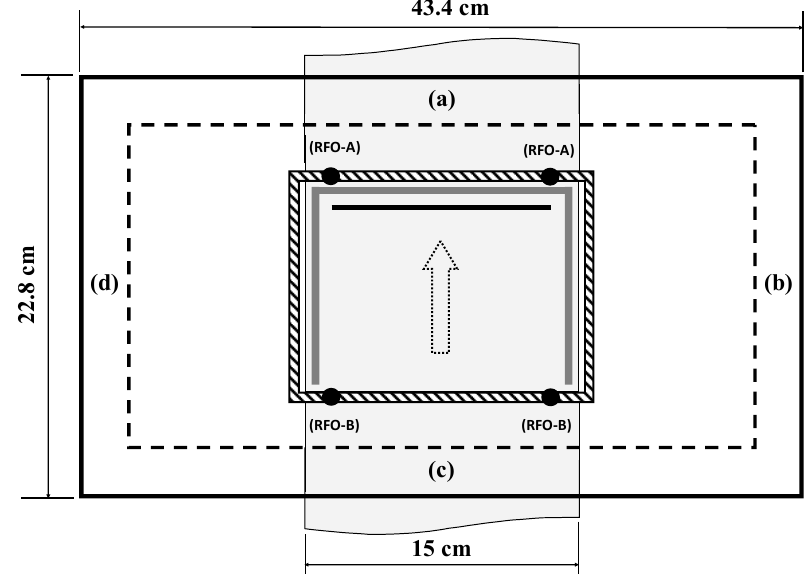
Figure 1. Schematic representation of the coating head components [15]. The dashed edges ( a – d ) represent the containment curtain flows (CCF), the single solid line represents the precursor delivery, the dark solid grey shaded line represents the flow guide plate, the hashed square represents the active exhaust, surrounding the deposition area, and the black dots (RFO-A and RFO-B) represent the extraction points. The discontinuous light grey band represents the substrate width, while the central arrow indicates the direction of travel [17]. RFO: restricted flow orifice. Reproduced with permission from MOCVD for solar cells, a transition towards a chamberless inline process; published by Elsevier, 2015.